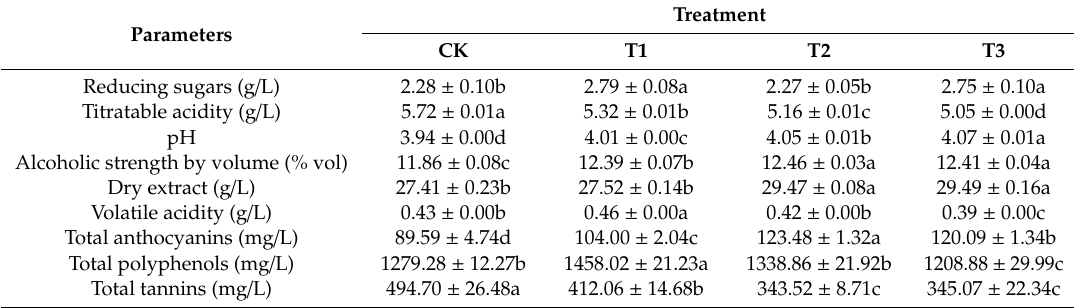
Table 2. General enological parameters composition of Cabernet Sauvignon wines made from control berries and sequential harvest